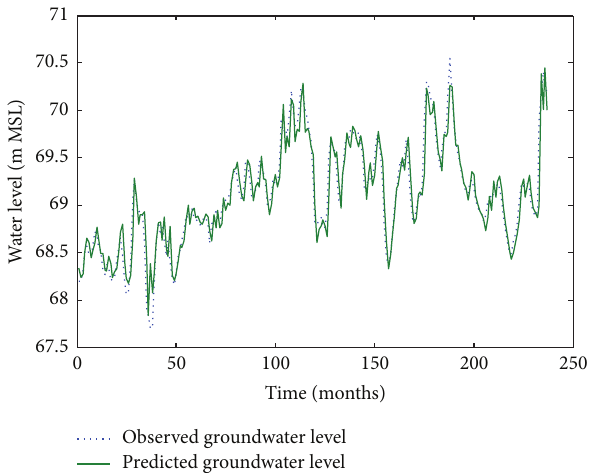
Figure 14: Comparison of observed groundwater levels with simu- lated results for 1 month ahead using an ANFIS model (Pp 928).